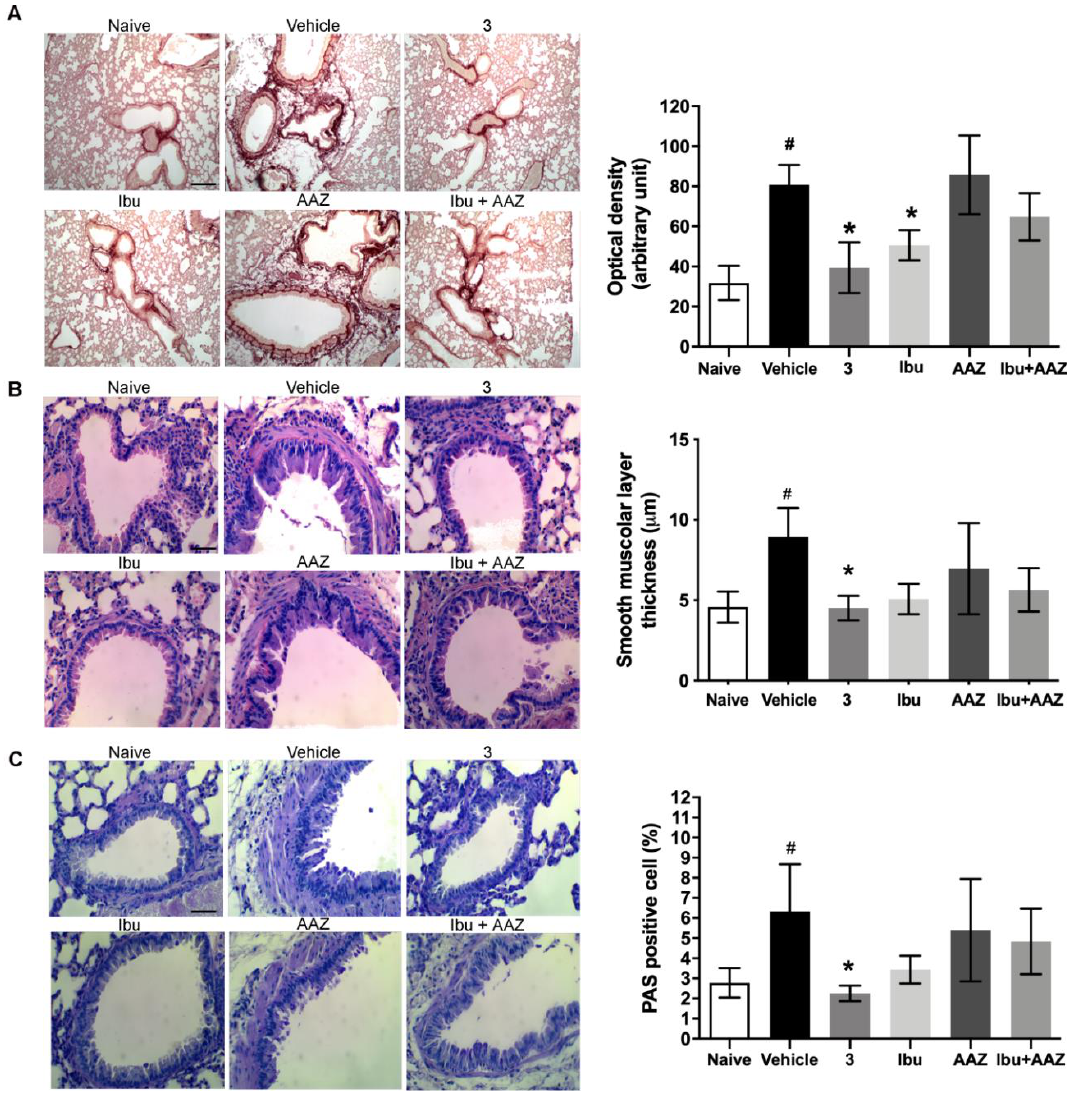
Figure 6. ( A ) Lung histology of collagen deposition. Histopathological evaluation of fibrosis by picro-sirius staining. By computer-aided densitometry analysis, it is possible to obtain a semiquantitative measure of this accumulation. n = 6 animals/group. Data are mean ± SEM, # p < 0.05 vs. Naive, * p < 0.05 vs. Vehicle. Scale bar, 100 µm ( B ) Histopathological evaluation of airway remodeling by hematoxylin-eosin staining. n = 6 animals/group. Data are mean ± SEM. # p < 0.05 vs. Naive, * p < 0.05 vs. Vehicle. Scale bar, 50 µm ( C ) Goblet cell number in PAS-stained lung sections (see the arrows) is evaluated in each experimental group. n = 6 animals/group. Data are mean ± SEM. # p < 0.05 vs. Naive, * p < 0.05 vs. Vehicle. Scale bar, 50 µm.